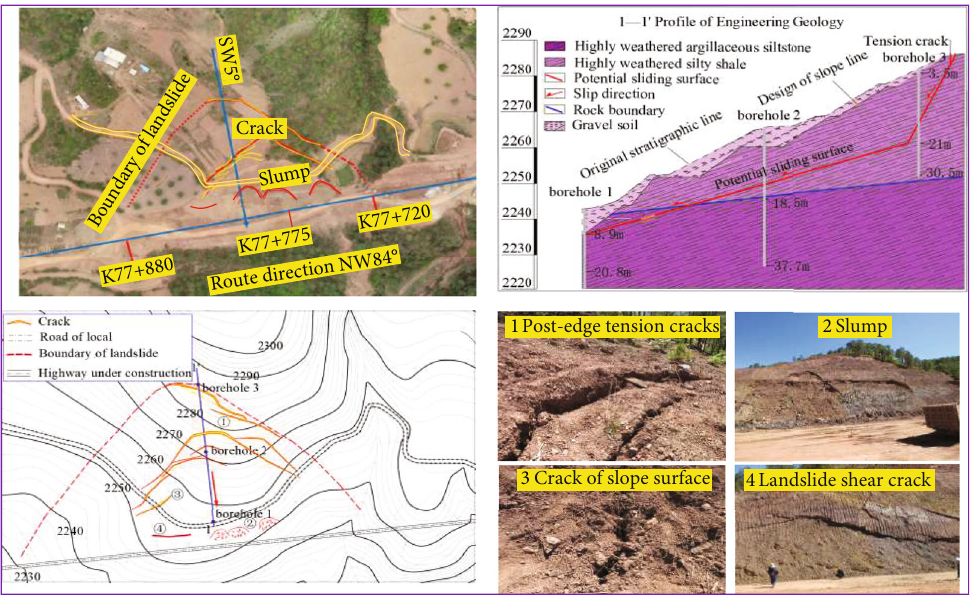
Figure 1: Overview of the landslide